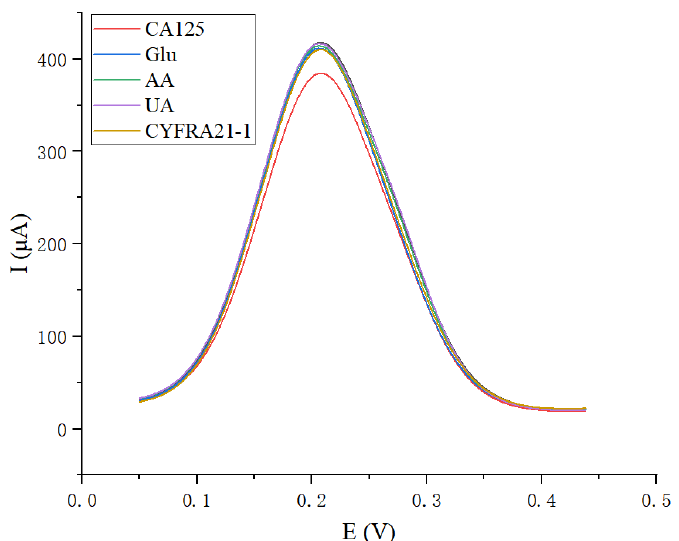
Figure 8. Differential pulse voltammetry curves of various interfering substances and CA125.